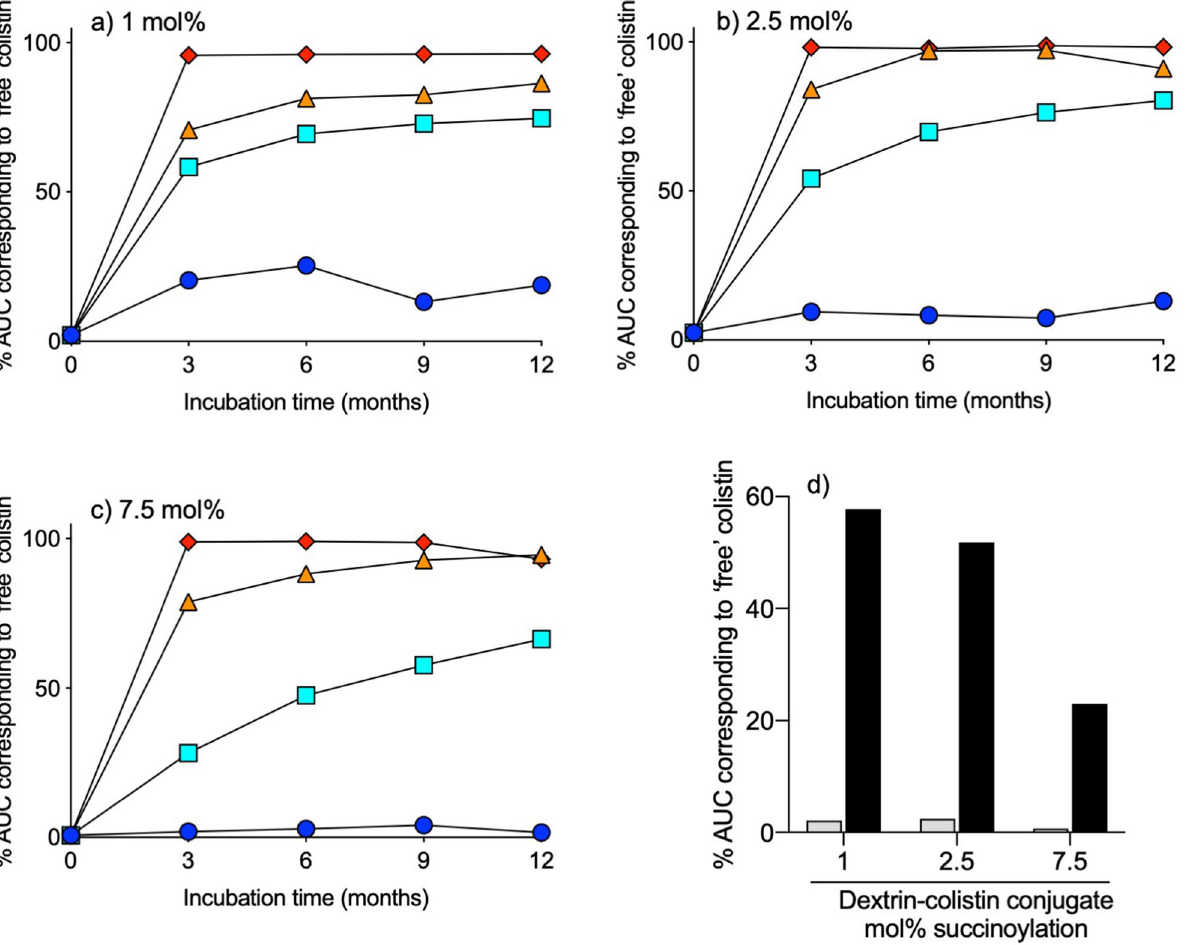
Figure 4. Release of free colistin from dextrin–colistin conjugates with ( a ) 1 mol%, ( b ) 2.5 mol% and ( c ) 7.5 mol% succinoylation following storage at -20 (dark blue circle), 4 (light blue square), 21 (orange triangle) or 37 (red diamond)°C for up to 12 months. Panel ( d ) shows release of free colistin from dextrin–colistin conjugates before and after exposure to weekly freeze-thawing for 5